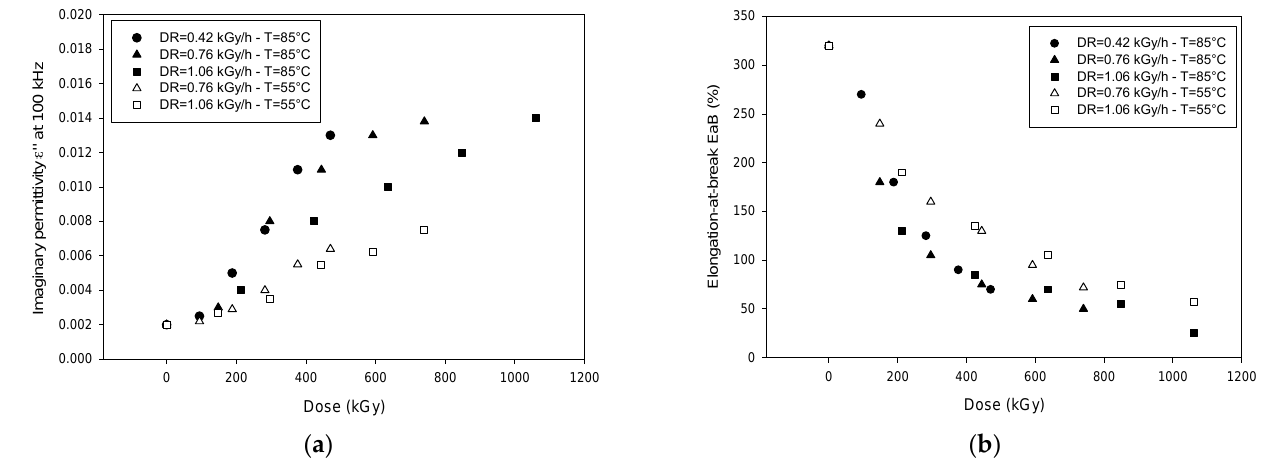
Figure 3. Imaginary part of the permittivity at 100 kHz ( a ) and elongation at break, EaB, ( b ) as a function of total absorbed dose for different combinations of dose rates and temperatures (after [15]).